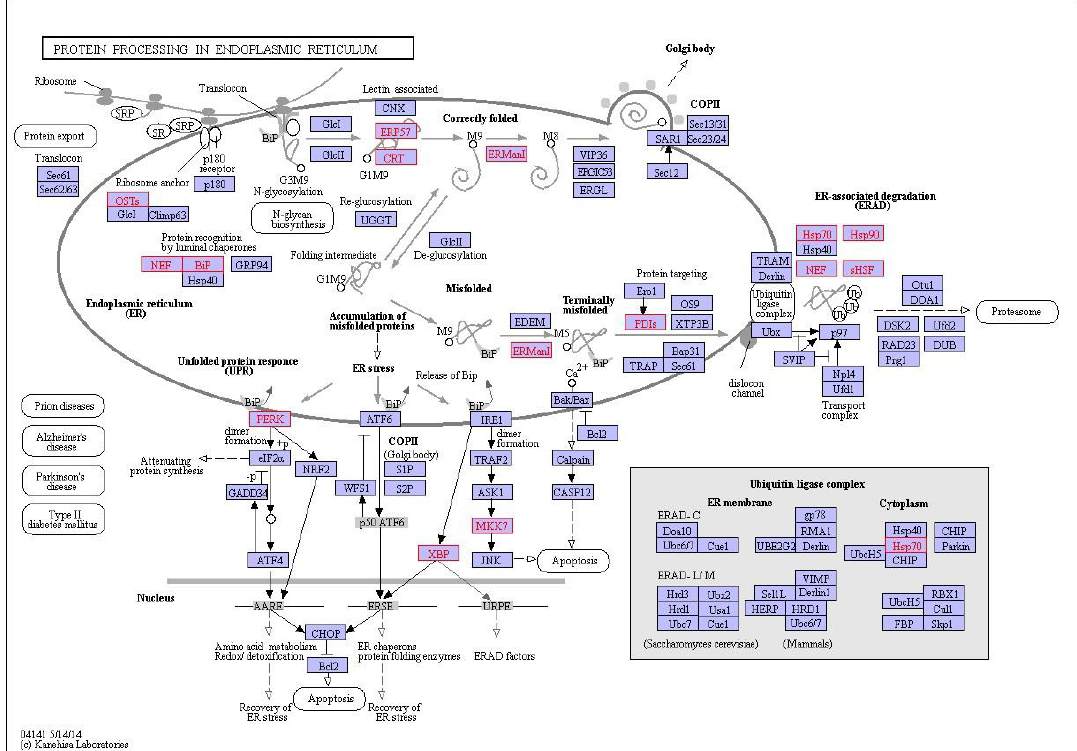
Figure 8. Interaction network of differentially expressed genes in the digestive gland of M. galloprovincialis involved in protein processing in the endoplasmic reticulum during exposure to 1 mg/L n C 60 . Genes which are differentially expressed during exposure are highlighted in